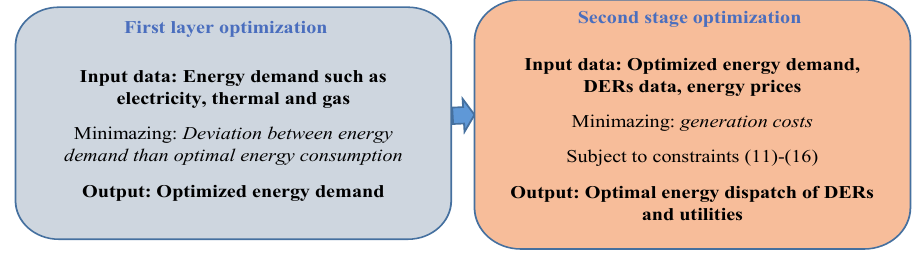
Fig. 3. Framework of the energy